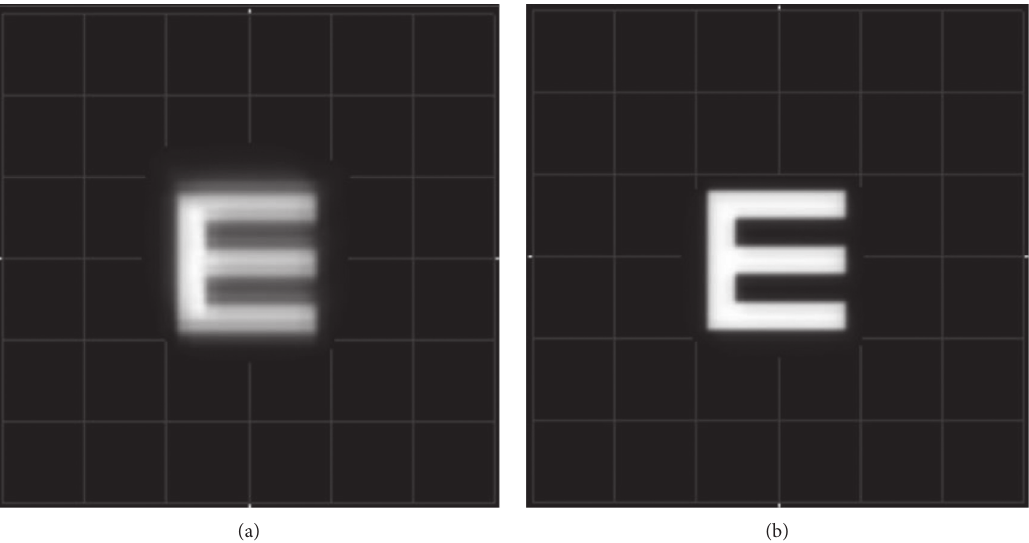
Figure 7: Simulated visual acuity images from the aberrometry measurements of a patient treated with topical ciclosporin A and hy- drocortisone before (a) and after therapy